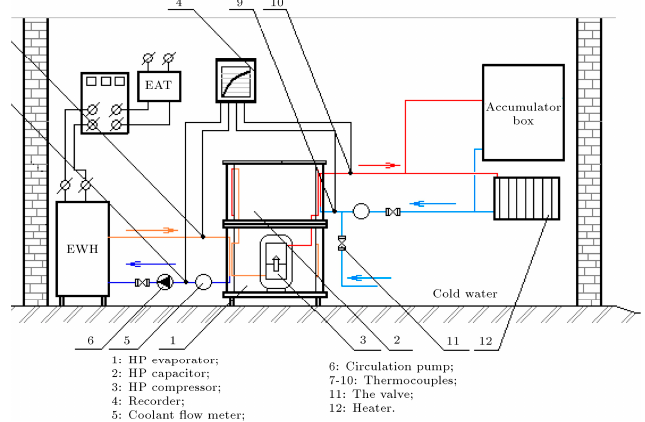
Figure 5. Industrial design and general view of a two-circuit solar installation.